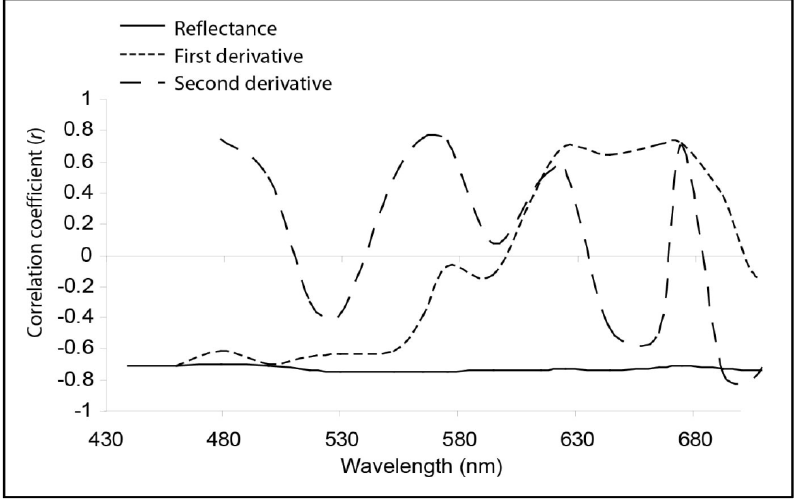
Figure 6. Correlogram of linear correlation coefficients between live coral cover and spectral reflectance, first derivative and second derivative.